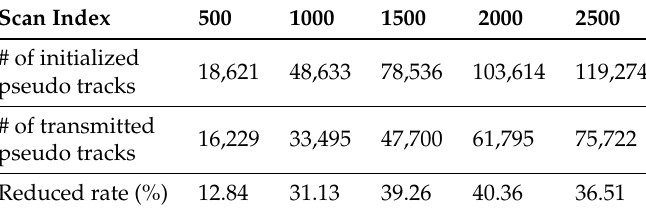
Table 3. Total number of initialized and transmitted pseudo tracks in sonar s 2 at case 3.